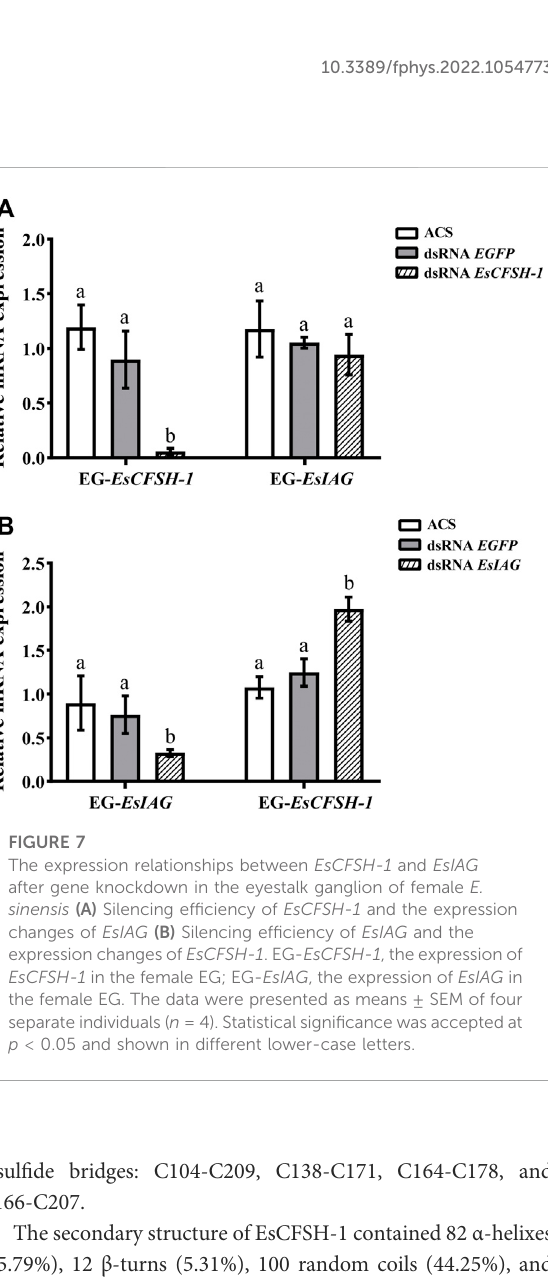
disul fi de bridges: C104-C209, C138-C171, C164-C178, and C166-C207.